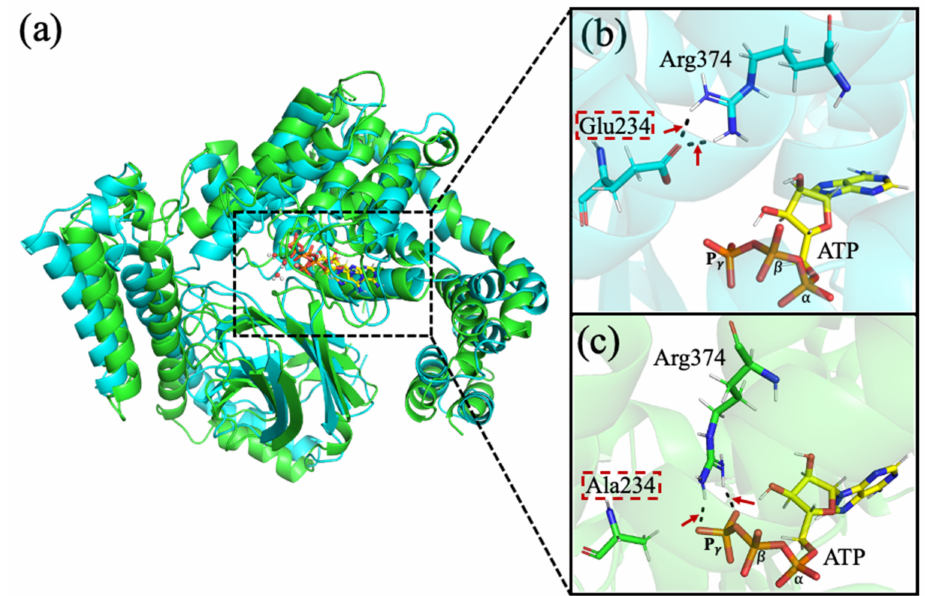
Figure 4. ( a ) Superimposition of MD equilibrated structures between HYPE-BiP with Glu234 complex (cyan) and HYPE-BiP with Ala234 complex (green). ( b , c ) Partial enlarged view of the area indicated by the dotted box in ( a ). ( b ) HYPE-BiP complex with Glu234 (arrow in ( b , c ) HYPE-BiP complex with Ala234 (arrow in ( c )). Hydrogen bonds are denoted with yellow dashed lines and coordinated bonds are denoted with black dashed lines. Binding site residues are shown as sticks and are colored according to the chain of origin. Atom color code used, Mg 2+ (pink), C (yellow) in ATP, P (orange), O (red), N (blue) and H (white). Asterisks denoted residues that originate from the substrate BiP protein, other residues are from the HYPE